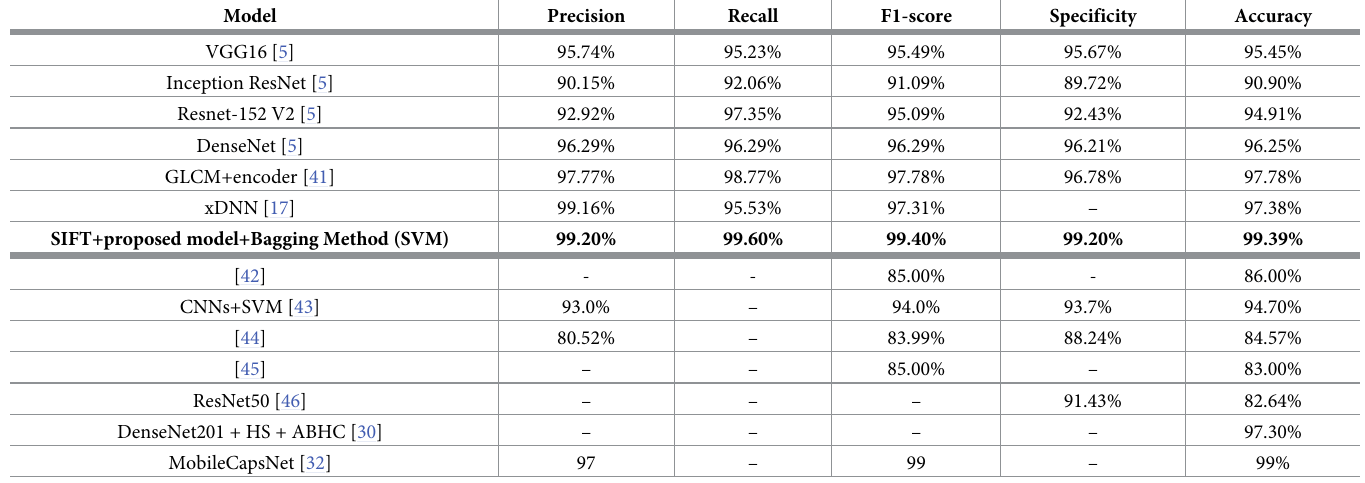
Table 3. Comparison of the proposed model and the state-of-the-art DL-based models for COVID-19